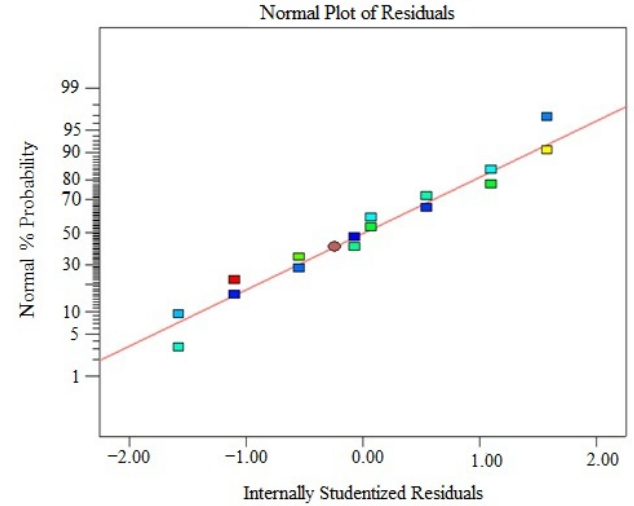
Figure 9. Normal probability plot of residual for the removal of PBV.